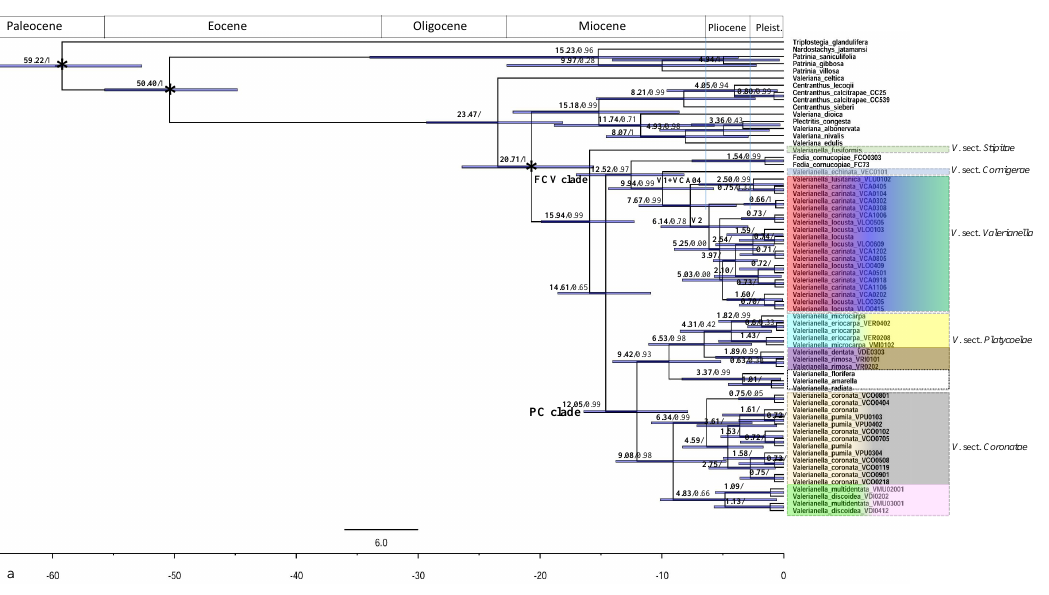
Figure 2. Maximum likelihood plastid trn L-F tree constructed with IQTREE showing the relationships between the Valerianella and Fedia species studied. Dipsacaceae sequences were used to root the tree (see Figure S1). FCV ( Fedia + V . sect. Valerianella clade), PC ( V . sects. Platycoelae + Coronatae clade). Numbers on branches indicate UltraFast Bootstrap support (BS) values. The icons show the different types of carpological traits (fruit and vestigial calyx) of the Valerianella species studied (reprinted and adapted with permission from Editorial Board from [6], Copyright 2007, Real Jard í n Bot á nico de Madrid-CSIC).